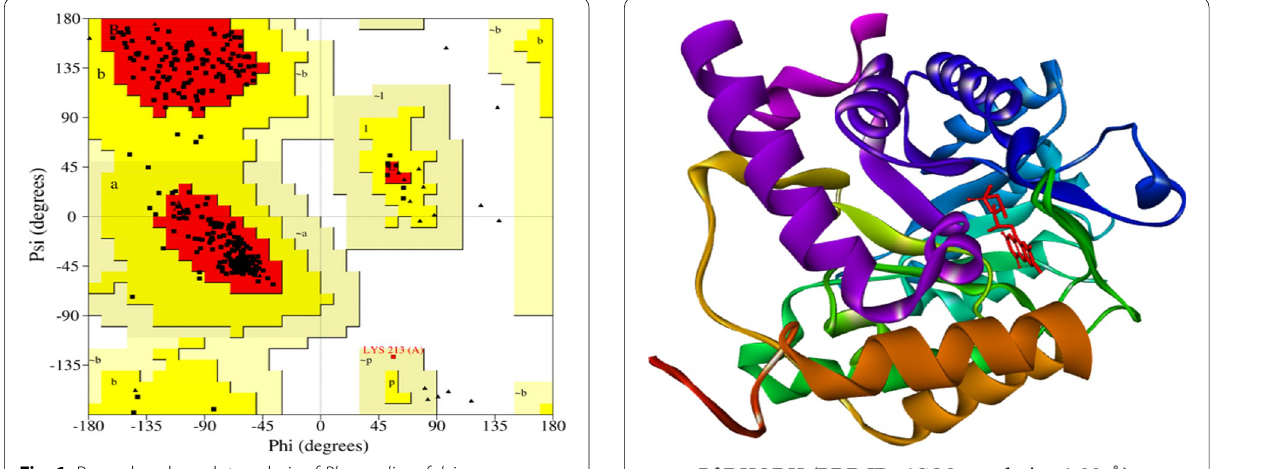
Fig. 1 Ramachandran plot analysis of Plasmodium falciparum dihydroorotate dehydrogenase, where the red region indicates the favored region, the yellow region for allowed and light yellow shows the generously allowed region, and white for the disallowed region. Phi and Psi angles determine torsion angles